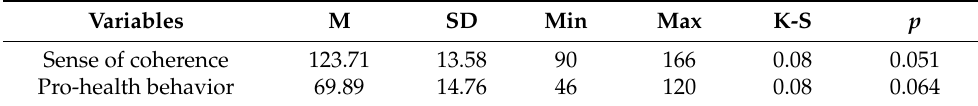
Table 2. Descriptive statistics for the analyzed interval